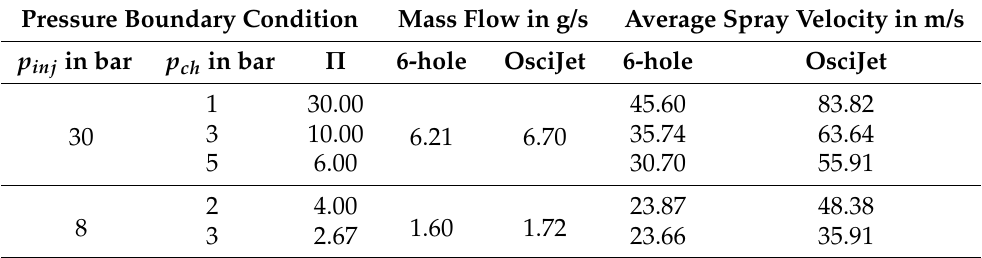
Table 1. Pressure boundary conditions and result variables for the investigated nozzle configurations ( Π = pressure ratio (injection pressure/chamber back